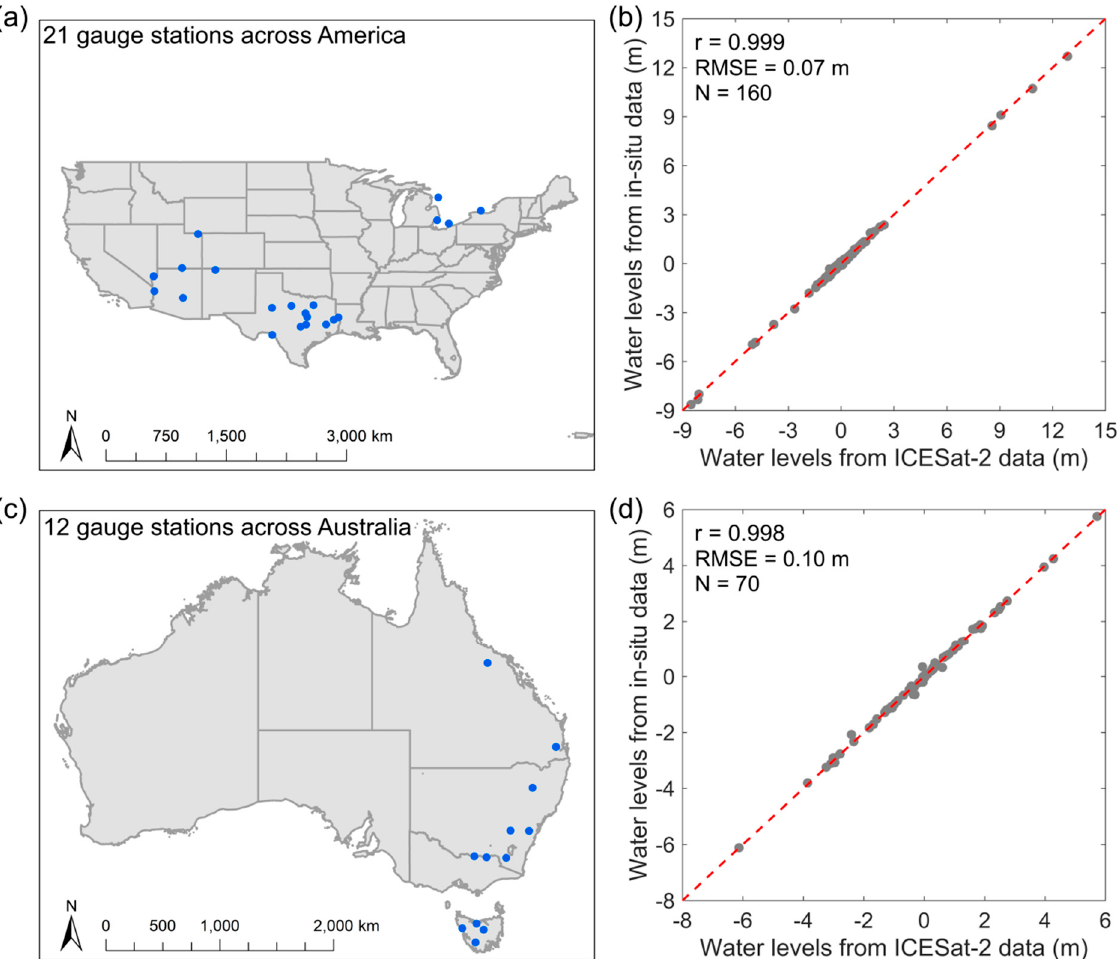
Figure 3. Validations of the lakes/reservoirs monthly water levels derived from ICESat-2 data. Maps of used gauge stations (blue dots) across the United States ( a ) and Australia ( c ) for the validation. Scatter plots between monthly water levels derived from ICESat ‐ 2 data and in situ data across the United States ( b ) and Australia ( d ). For the United States, in situ data from 21 lakes/reservoirs were used for the comparison with 160 monthly water levels. For Australia, in situ data from 12 lakes/reservoirs were used for the comparison with 70 monthly water levels. For each lake/reservoir, all monthly water levels were offset to make water levels from ICESat ‐ 2 data and in situ data comparative. In ( b , d ), the red dash line represents the 1:1 line.